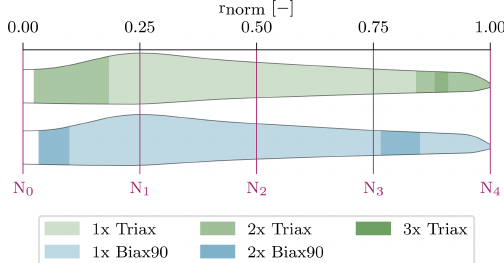
Figure 14. Layup of the sandwich laminate face sheets of the blade shell, consisting of Triax and Biax90 ◦ . The inner and outer face sheets are symmetric.